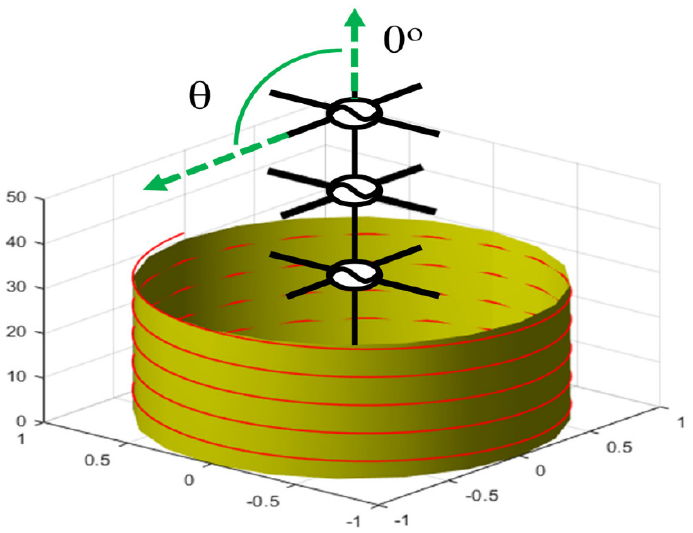
Figure 4. Array of crossed dipoles inside the cylindrical radome.